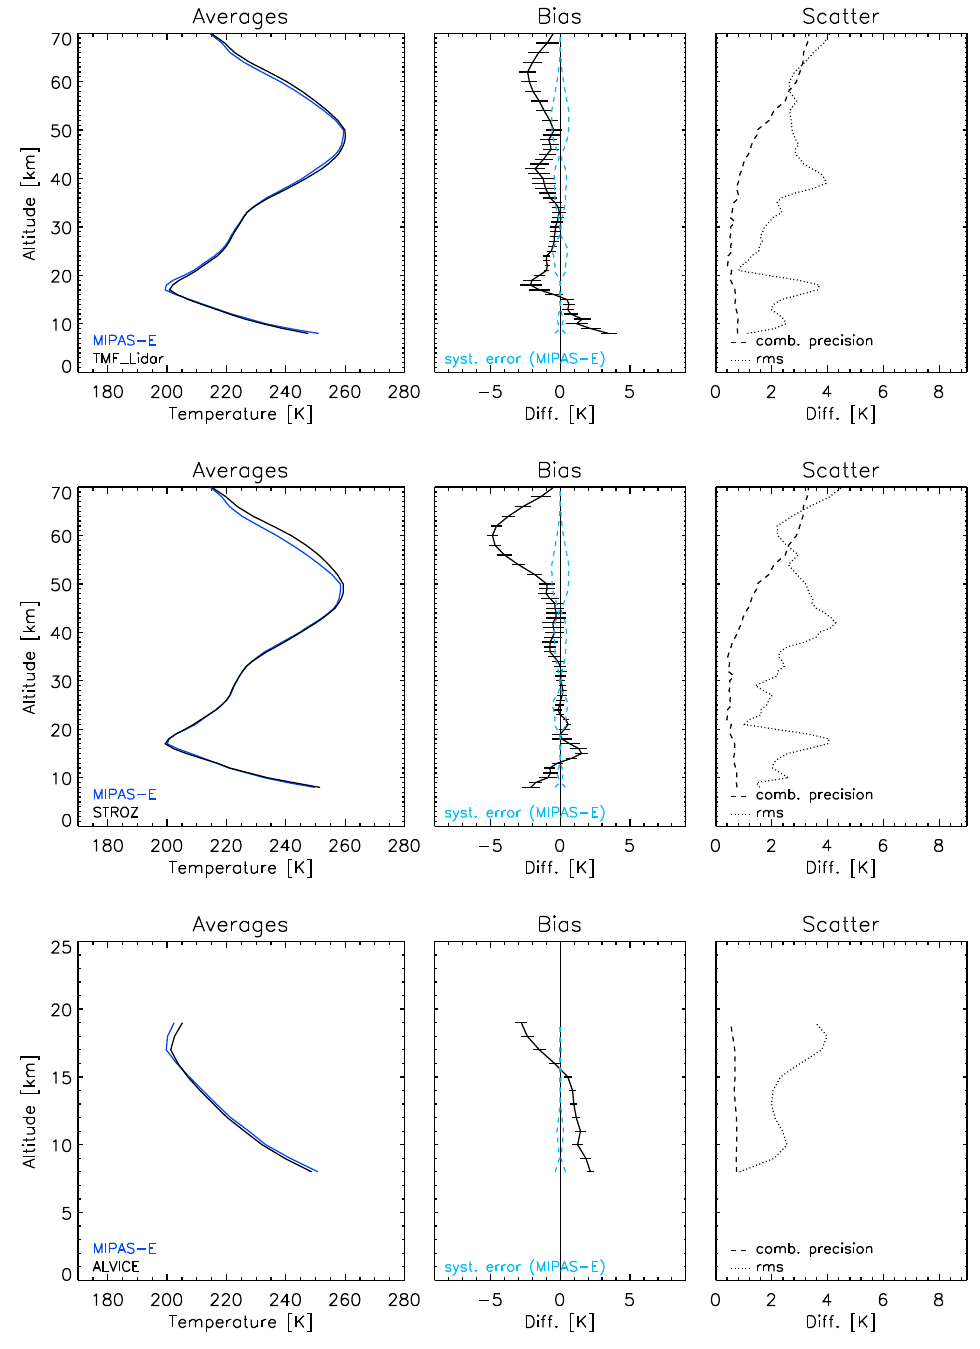
Fig. 2. Top row, left panel: average over all MIPAS temperature profiles (blue) for which coincidences with TMF lidar profiles have been found, together with the average of degraded TMF lidar profiles (black) which are coincident with the MIPAS profile. Top row, middle panel: Averaged absolute differences together with their standard errors of the mean (error bars) and the combined systematic error components of the two measurements (dashed lines). Top row, right panel: Bias-corrected root mean squares (rms) differences (dotted line) and the combined precisions of individual MIPAS and TMF lidar profiles (dashed line). Middle row: Same as top row, but for STROZ lidar temperature profiles. Bottom row: Same as top row, but for ALVICE lidar temperature profiles.